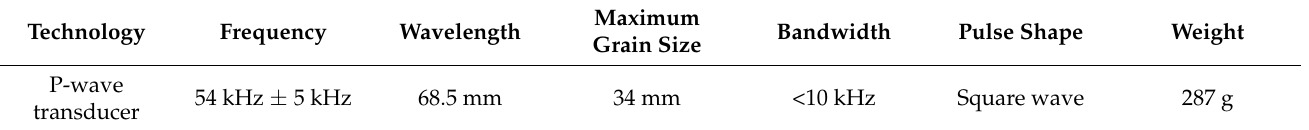
Figure 6. Some specifications on sensors and their use. ( a ) Transducer diameter and transducer length; ( b ) 2 transducers, 2 BNC cable and couplant + calibration rod. Table 1. Technical specifications of the sensors used in our NDT experiments.